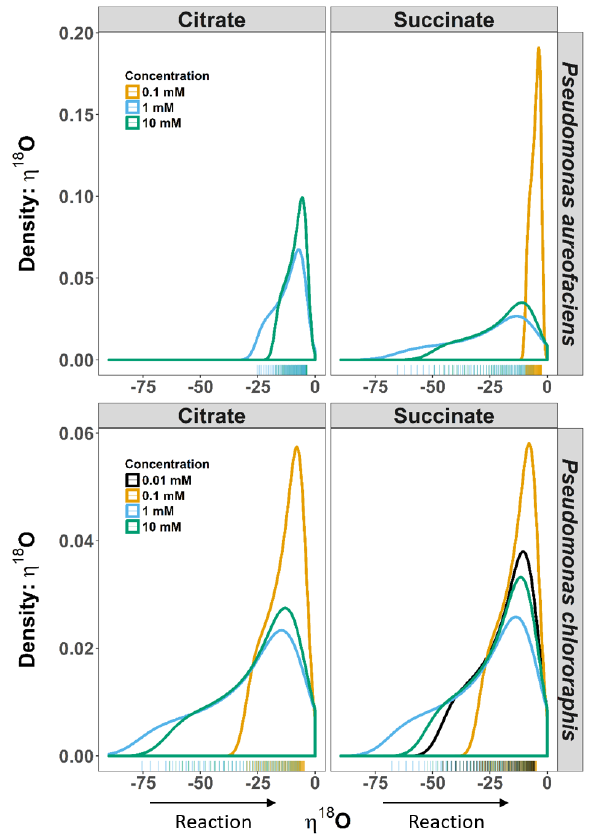
Figure 3. Density distributions (DDs) of δ 18 O net isotope ef- fects ( η ) estimated from the derivative of an exponential function describing the relationship between δ 18 O and [ − f ln f/( 1 − f ) ] for Pseudomonas aureofaciens (orange) and Pseudomonas chloro- raphis (blue). The estimates of η are extrapolated to include the complete extent of the reaction. The left panel displays the DDs for citrate treatments and the right panel displays DDs for succinate treatments. Positive values of η were not observed during reactions. Tally marks at the base of each panel indicate the actual distribution of calculated